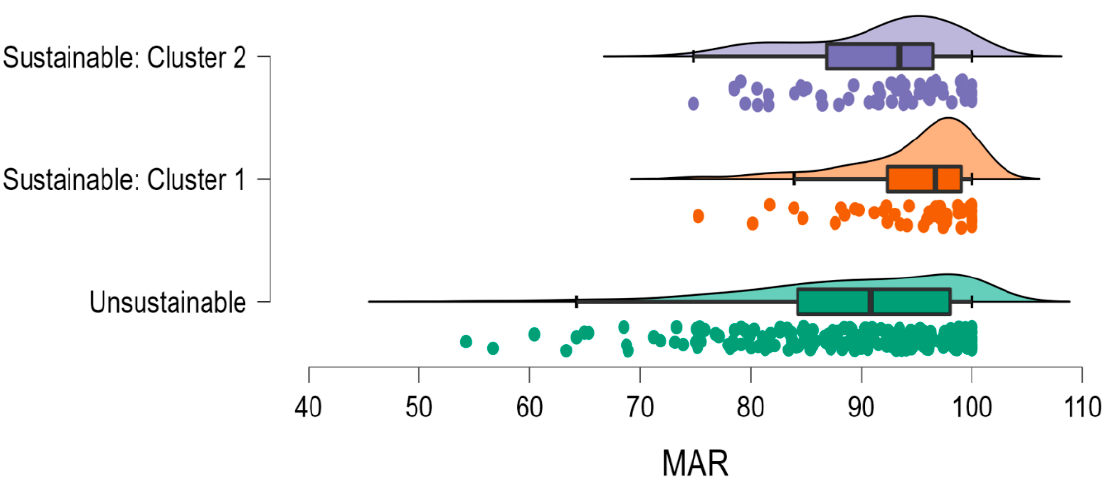
Figure 3. Raincloud plot showing raw data, density, boxplots, and means with 95% CI for the Mean Adequacy Ratio. n = 216, n = 54, and n = 57 for unsustainable, Cluster 1, and Cluster 2, respectively. MAR = Mean Adequacy Ratio. Those in Cluster 1 consumed a more nutrient-dense diet than those consuming an unsustainable diet ( p < 0.001) or those in Cluster 2 ( p < 0.01). MAR did not differ between those consuming an unsustainable diet and those in Cluster 2 ( p = 0.851).